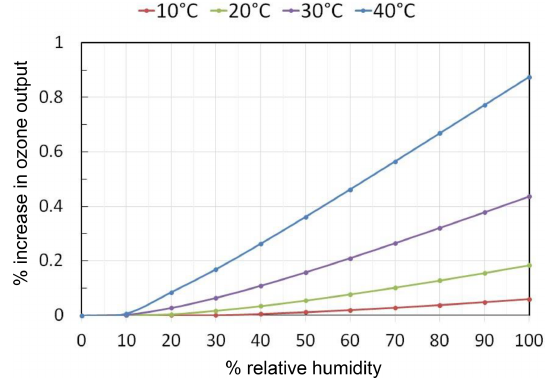
Figure 6. Calculated percent increases in the ozone mixing ratio output (for a target of 100ppb of O 3 ) from the ozone calibration source due to photochemical reactions as a function of temperature and relative